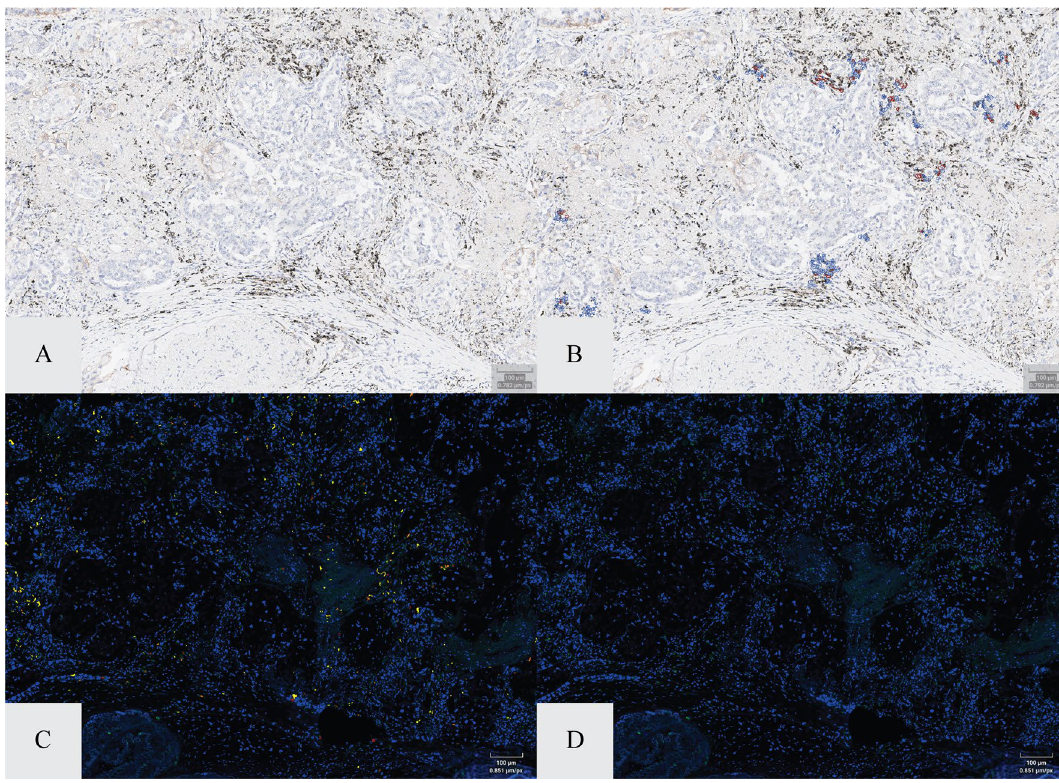
Figure 2. IA vs. double immunofluorescence of lymphocyte identification. Panel ( A ) and ( B ) show PD-L1 stained tumor field of view with and without the lymphocyte labeling (red = PD-L1 positive; blue = PD-L1 negative). Panel ( C ) and ( D ) represent corresponding field of view in a serial section stained with CD3 (green) and CD20 (red).